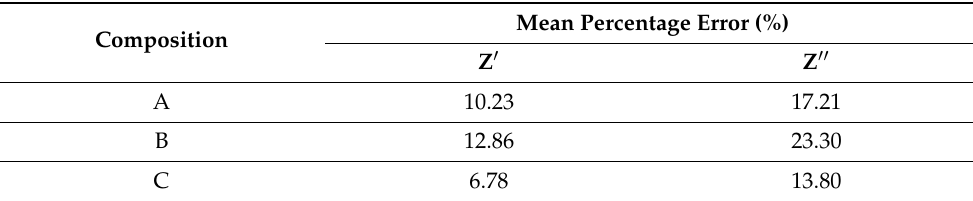
Table 5. Mean percentage errors for comparison between measured and simulated Z (cid:48) and Z (cid:48)(cid:48) for scaffold composites at